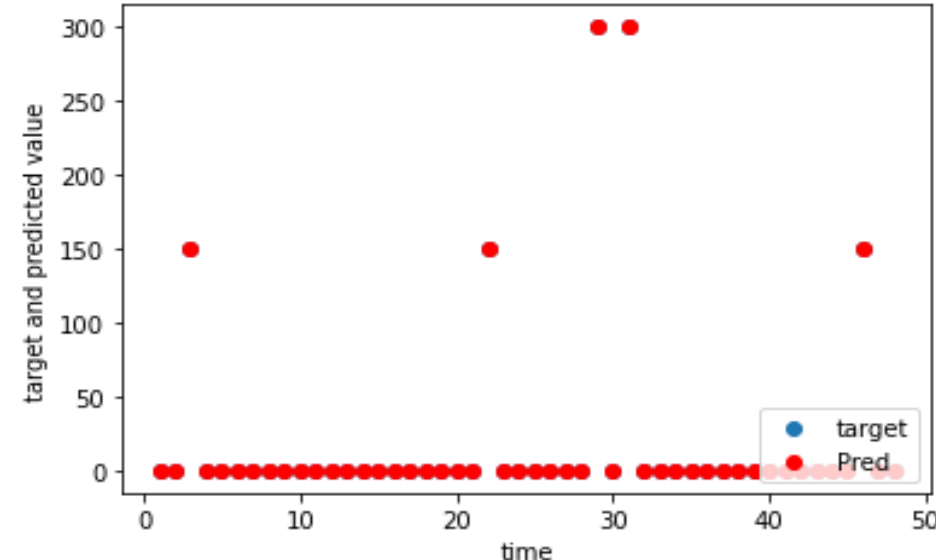
Figure 17. Charging demand prediction of a weekday for Leppävaaran asema.